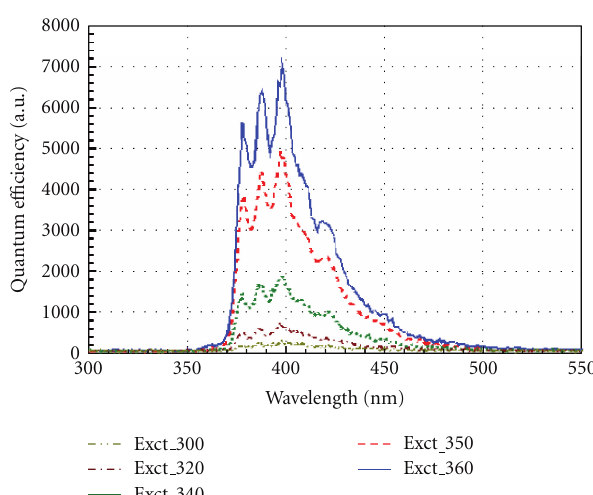
Figure 4: Fluorescence spectrum of 1,2 :3,4-dibenzanthracene in ethanol.